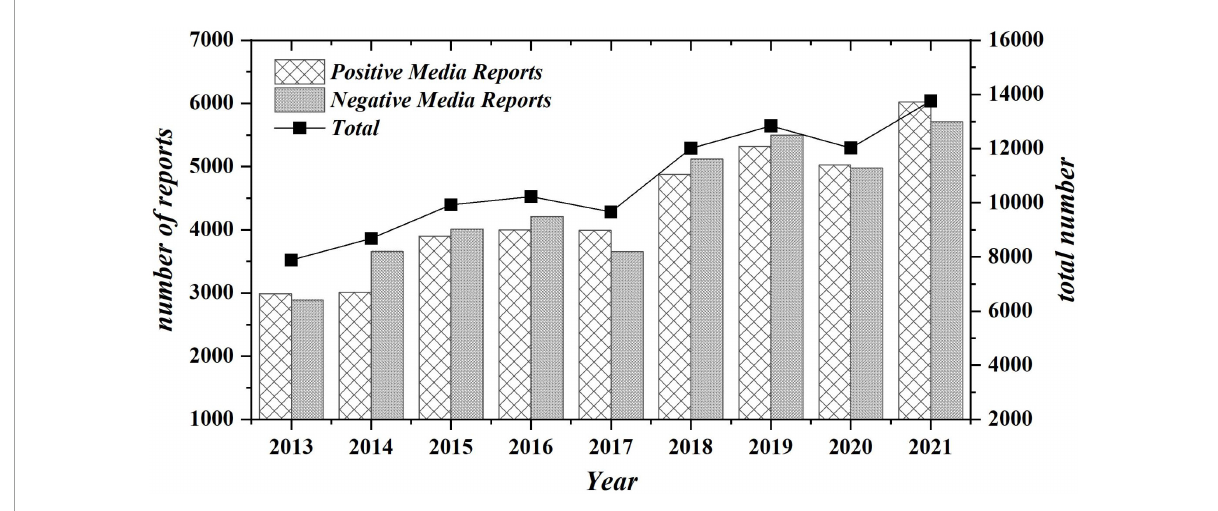
FIGURE1 Times of mainstream media reports on listed companies from 2013 to